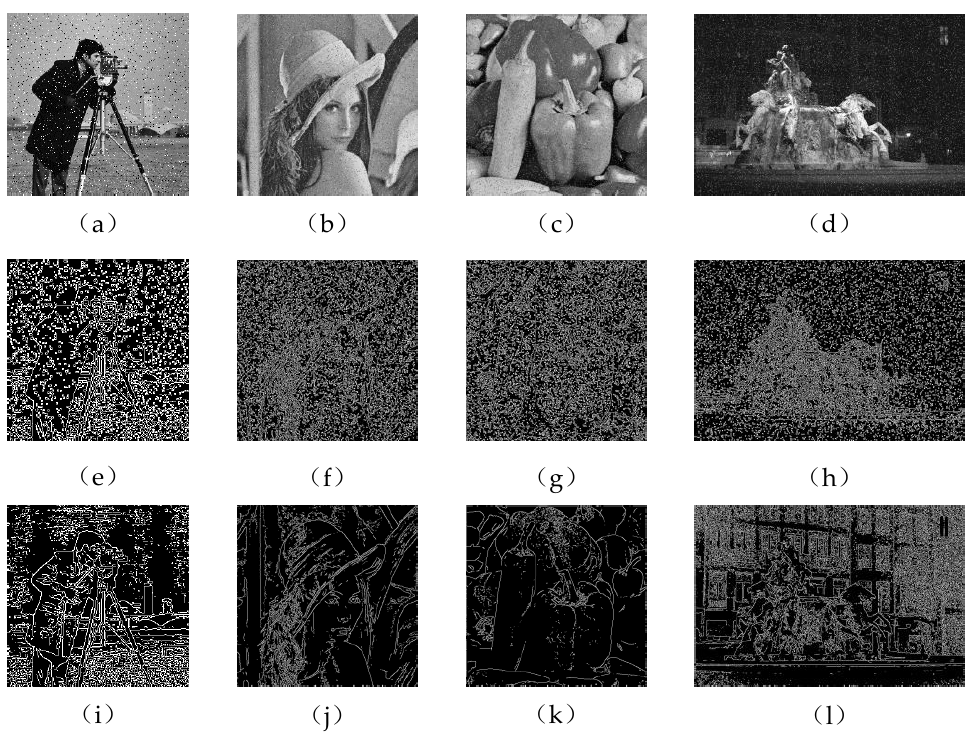
Figure 8. Comparison diagram of improved Canny algorithm and traditional Canny algorithm, ( a – d ) are the noisy images, ( e – h ) are the edge detection results using Canny respectively, ( i – l ) are the edge detection results using proposed method respectively.